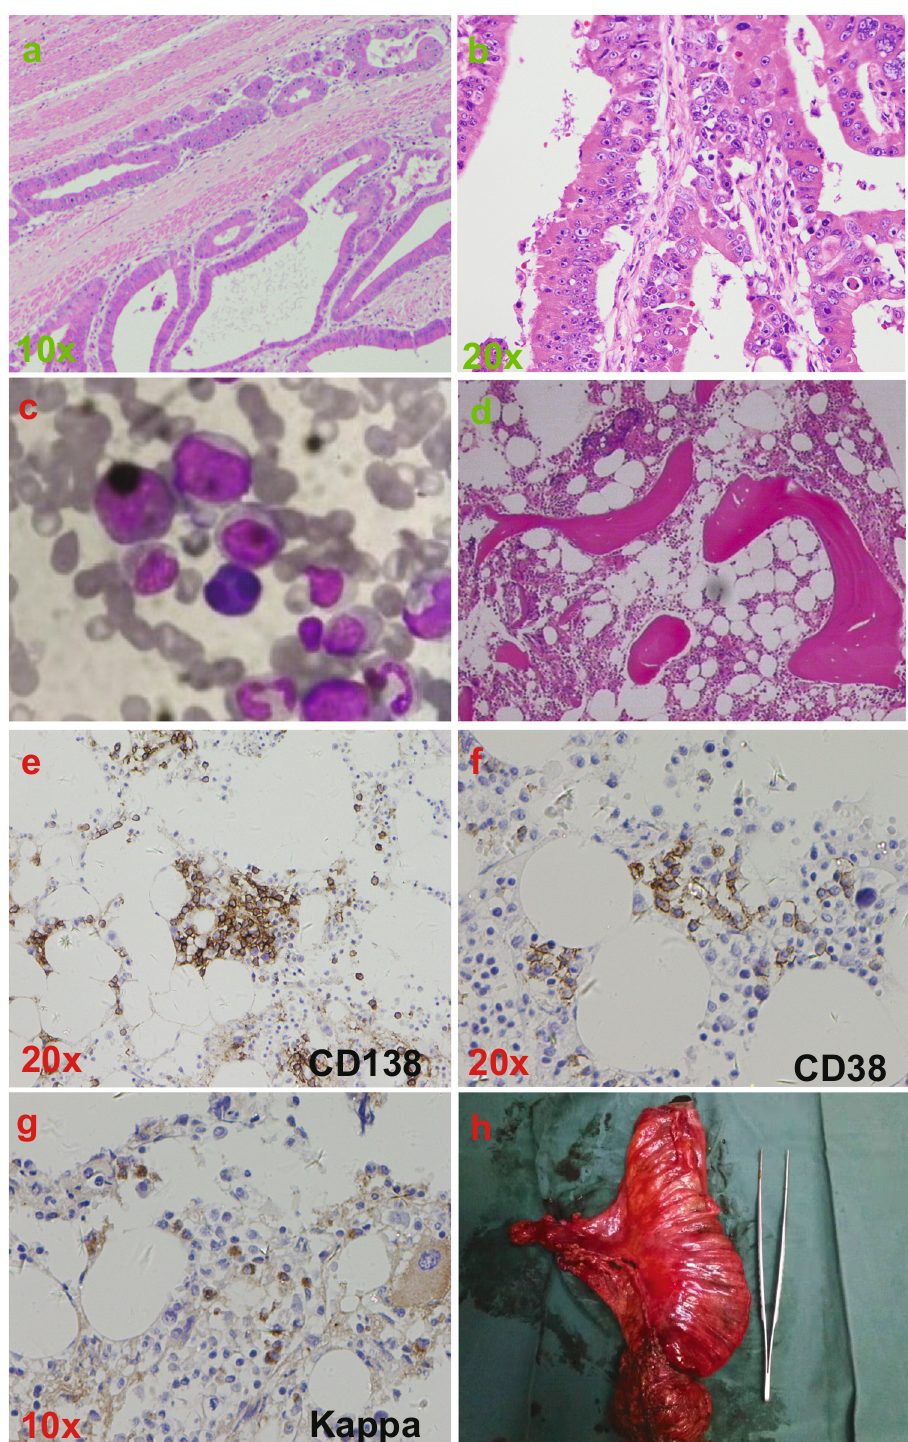
Figure 1: Clinical and histopathological appearances. ( a and b ) HE staining results from thickened rectum showing adenocarcinoma. ( c ) Bone marrow cytology results showing increased plasmocyte. ( d – g ) Pathological and immunohistochemical results of bone marrow showing CD138 (+) , CD38 (+) , CD56 ( partial +) , Kappa (+) , myelodysplastic activity and increased plasmocyte. ( h ) Excised rectal